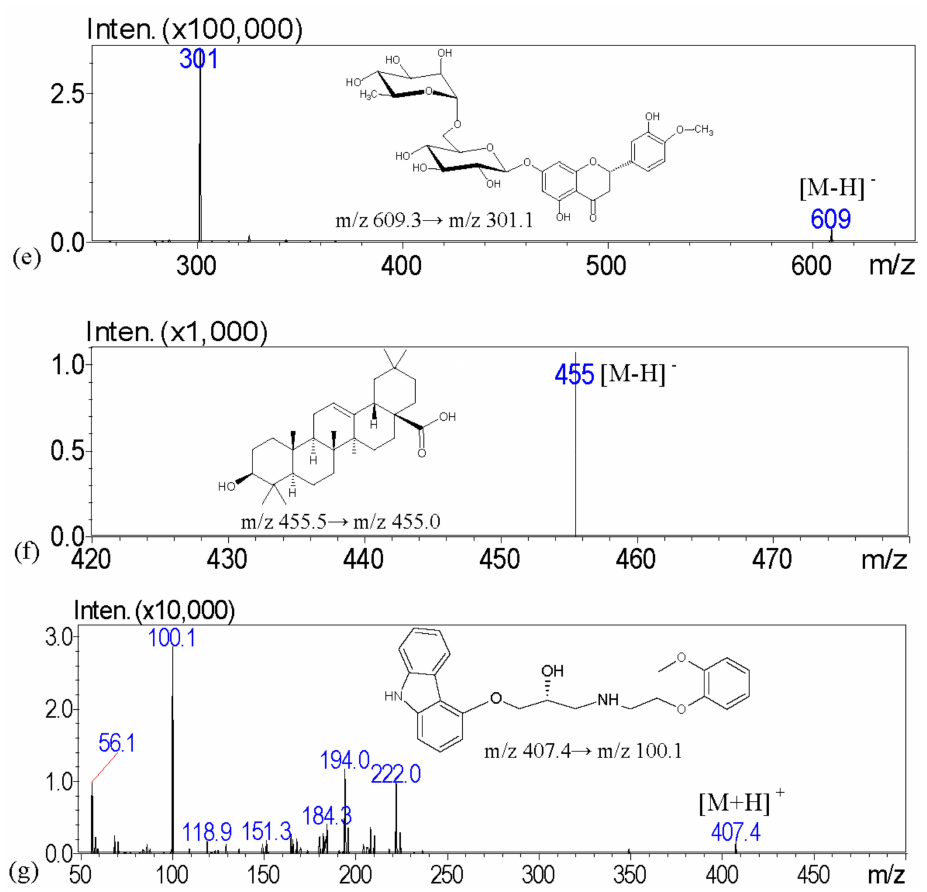
Figure 1. The product ion mass spectra of six marker compounds, including ( a ) guanosine; ( b ) atractylenolide III; ( c ) glycyrrhizic acid; ( d ) dehydrocostus lactone; ( e ) hesperidin; ( f ) oleanolic acid; and ( g ) carvedilol (internal